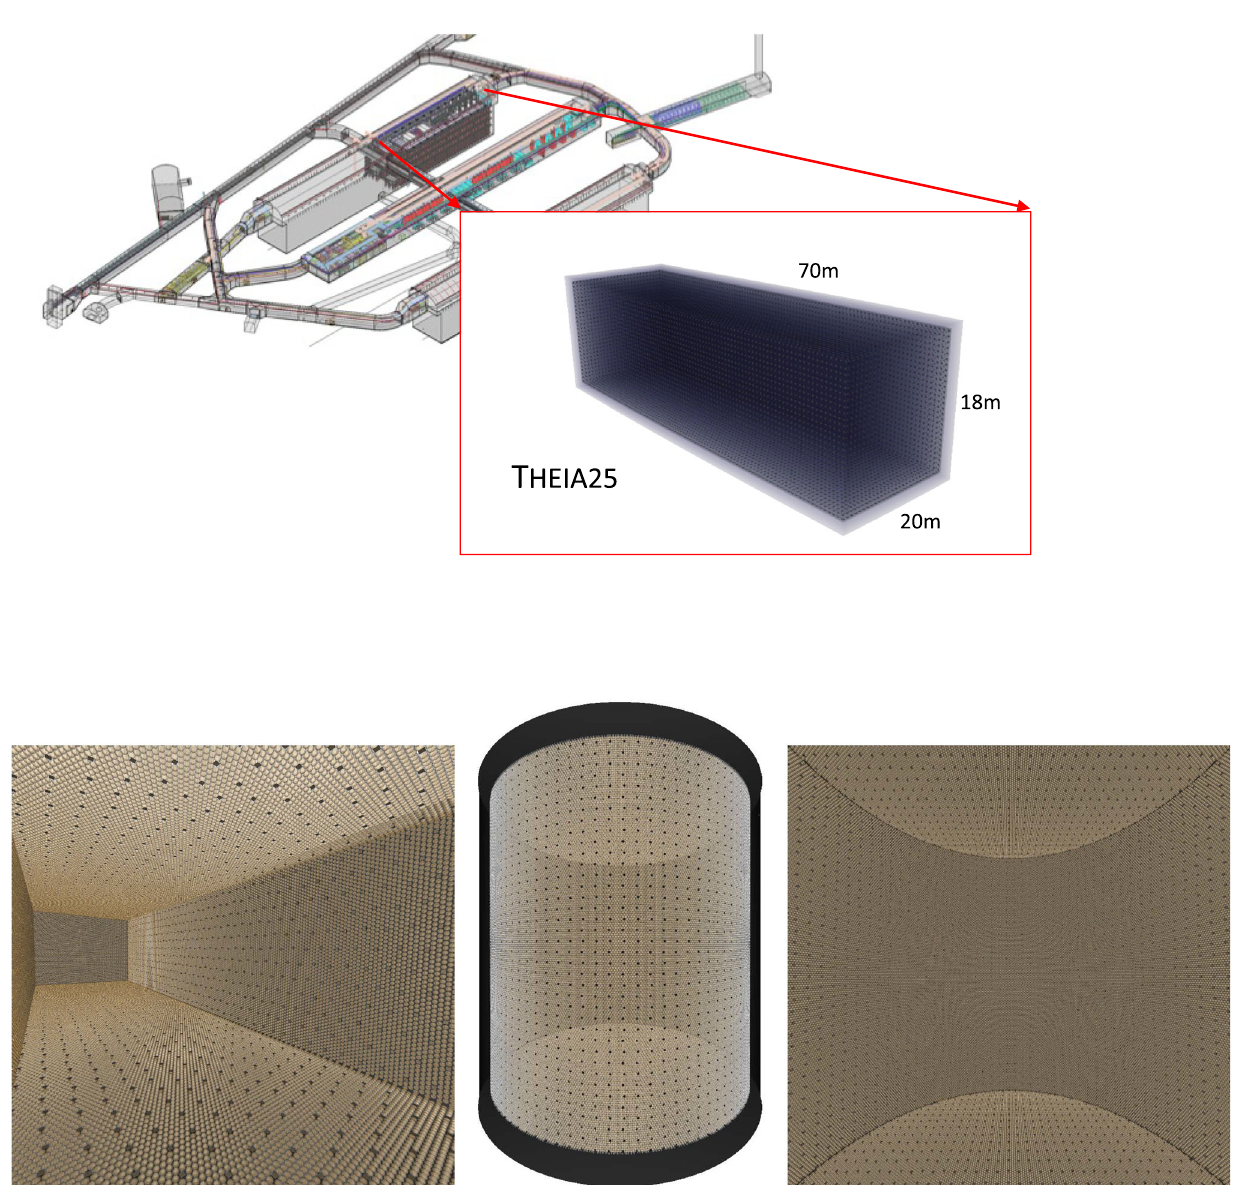
Fig. 1 The Theia detector. Top panel: Theia -25 sited in the planned fourth DUNE cavern; lower left panel: an interior view of Theia -25 modeled using the Chroma optical simulation package [27]; lower mid- dle panel: exterior view of Theia -100 in Chroma; lower right panel: